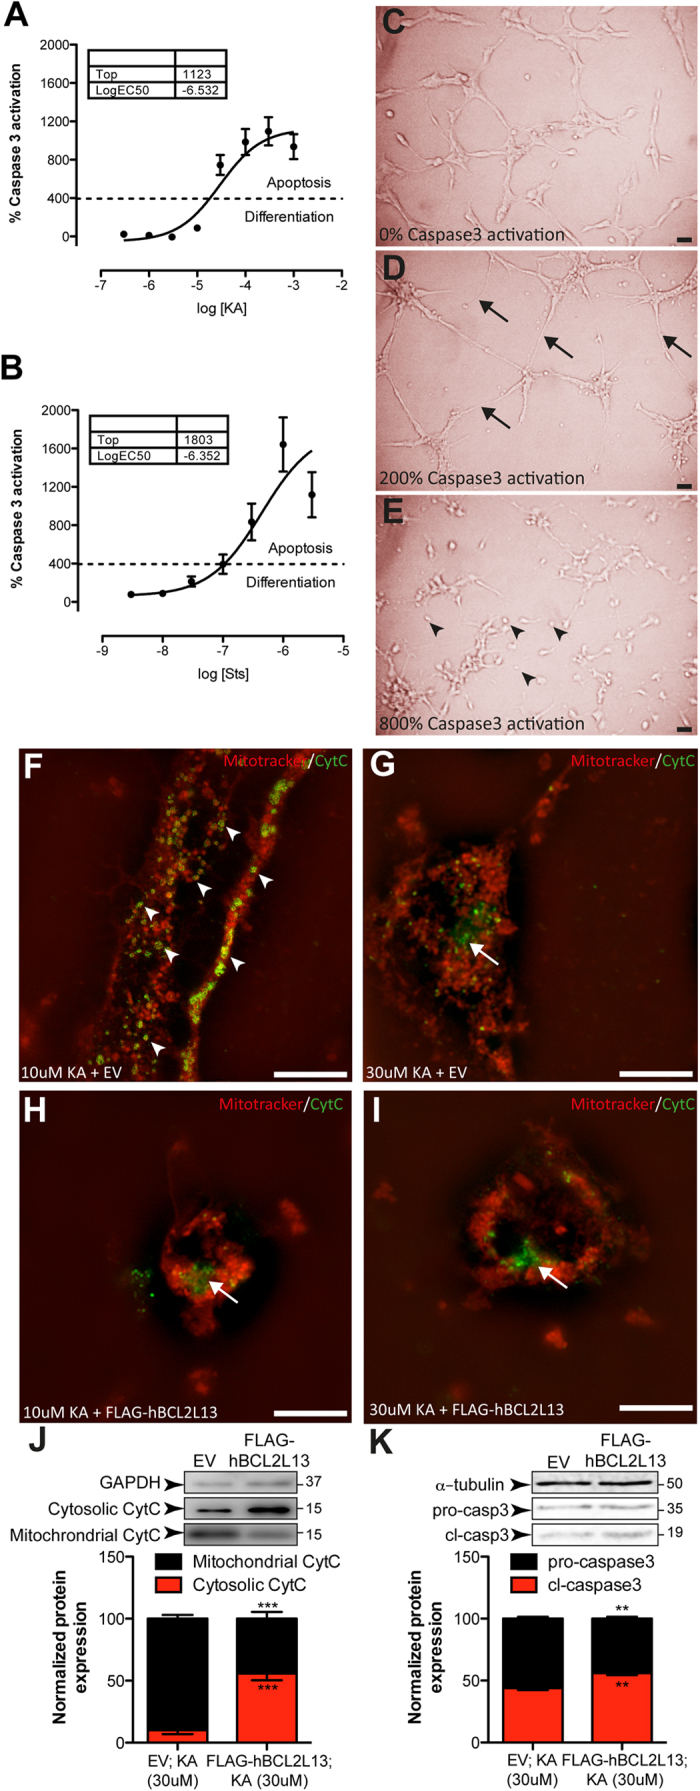
Effect of KA and exogenous BCL2L13 expression on CytC release from mitochondria and casp3 activation in hippocampal NSPC cultures.(A) Treatment with increasing concentrations of KA. Values are expressed as casp3 activity normalized to vehicle treated cells. (B) Treatment with increasing concentrations of Sts. Values are expressed as casp3 activity normalized to vehicle treated cells. Dashed lines represent the transition from differentiation to apoptosis. (C) Cell morphology under vehicle treatment conditions. (D) Cell morphology after treatment with 10 μM KA, inducing low casp3 activity (200% increase) as shown in (B). Arrows: cells displaying thinning and neurite extension. (E) Cell morphology after treatment with 30 μM KA, inducing higher amounts of casp3 activity (800% increase) as shown in (B). Arrowheads: shrunk cells. (F) SIM image showing details of hippocampal NSPC after 10 μM KA treatment. Arrowheads: CytC immunoreactivity in Mitotracker + mitochondria (yellow). (G) SIM image showing details of hippocampal NSPC after 30 μM KA treatment. Arrows: CytC immunoreactivity outside Mitotracker + mitochondria (green). (H) SIM Image showing details of hippocampal NSPC transfected with FLAG-hBCL2L13 after 10 μM KA treatment. White arrow points to CytC immunoreactivity outside Mitotracker + mitochondria (green). (I) Representative SIM micrograph showing hippocampal NSPC transfected with FLAG-hBCL2L13 after 30 μM KA treatment. Arrow: CytC immunoreactivity outside Mitotracker + mitochondria (green). Cells shown in (F and G) were transfected with EV for comparison to FLAG-hBCL2L13 (H and I). (J) Effect of 30 μM KA treatment in combination with EV or FLAG-hBCL2L13 on CytC localization. FLAG-hBCL2L13 transfection decreased the ratio of mitochondrial to cytosolic CytC expression significantly, compared to EV transfection (***p < 0.001). (K) Effect of 30 μM KA treatment in combination with EV or FLAG-hBCL2L13 transfection on casp3 activation. FLAG-hBCL2L13 transfection decreased the pro-casp3/cl-casp3 ratio significantly, compared to EV transfection (**p < 0.01). Scale bars: 10 μm (C–E); 3 μm (F–I). Values represent normalized mean (% of vehicle or EV) ± SEM of three independent experiments performed in triplicates.